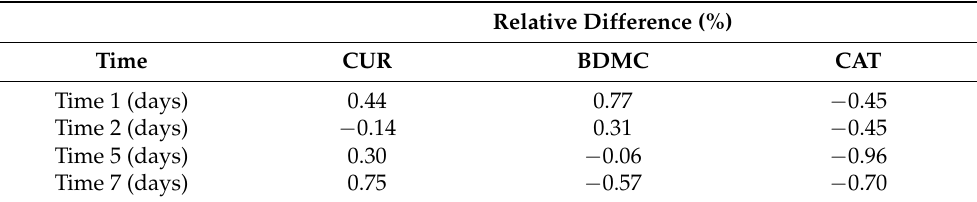
Table 4. Results obtained for the stability of the curcuminoid solutions stored at room temperature for 7 days. The stability was considered as the relative difference of the area response of 3.125 µ g/mL of curcuminoid solution between each stability time point and the freshly prepared solutions. Relative Difference (%)